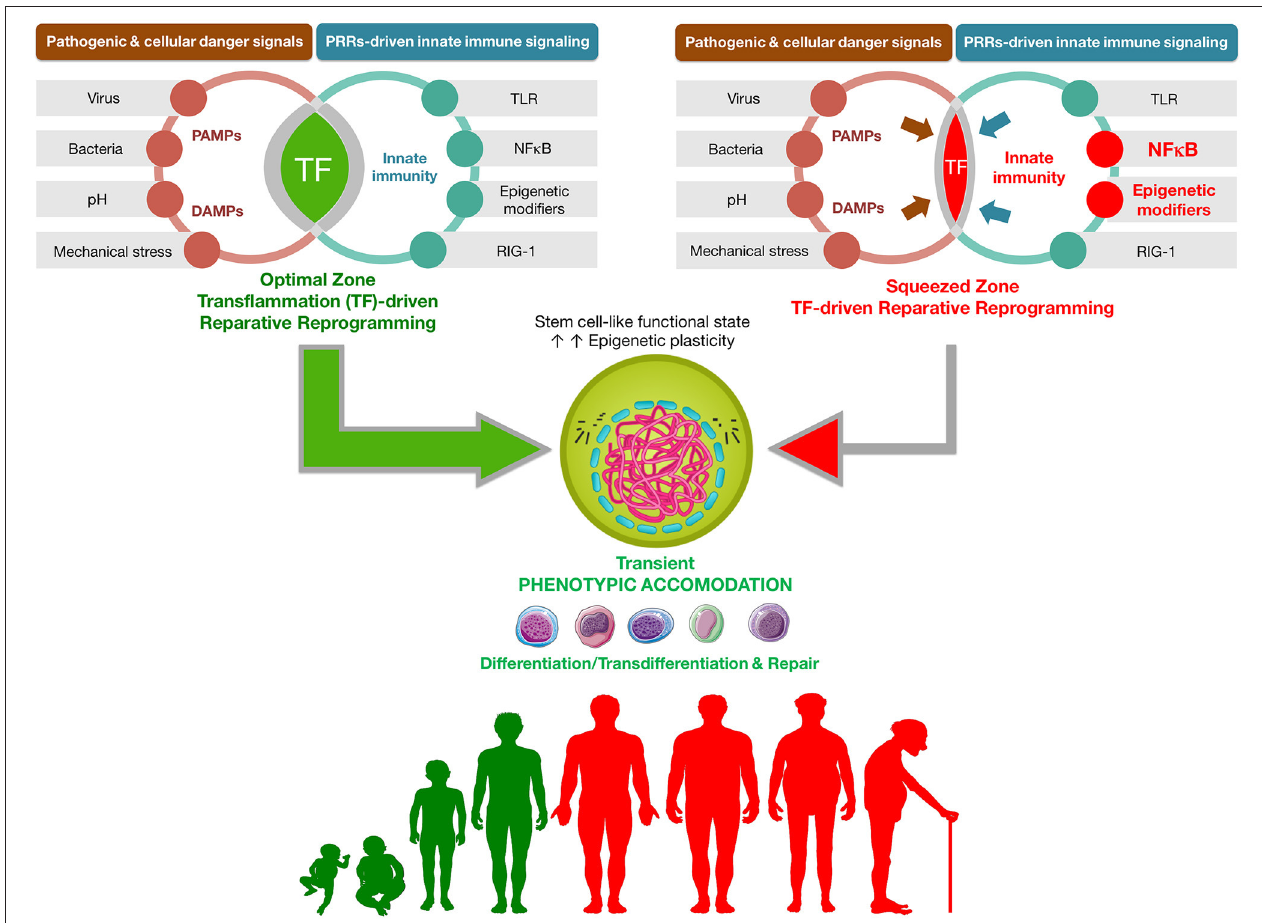
FIGURE 1 | Transflammation-driven epigenetic plasticity: a paradigmatic example of in vivo reparative reprogramming. Transient activation of the PAMPs-DAMPs → NF κ B signaling axis may delineate an optimal zone of transflammation (TF)-driven reparative reprogramming characterized by increased epigenetic plasticity and phenotypic malleability capable of responding and adapting to injury, stress, and disease ( Lee et al., 2012; O’Neill, 2012; Cooke et al., 2014). The efficiency of NF κ B signaling and the level of inflammatory responses is the nodal point linking the pathogenic assault and cellular danger signals and the organization of cellular resistance and tissue repair. NF κ B hyperfunction and its interaction with epigenetic modifiers would significantly squeeze the optimal zone of TF-driven reparative reprogramming, thus impairing the adequate organization of defense mechanisms. By operating as the perpetrator of inflammaging, the NF κ B signaling integrates the intracellular regulation of transflammation immune responses in both aging and aging-related diseases (Salminen et al., 2008; Montgomery and Shaw, 2015).